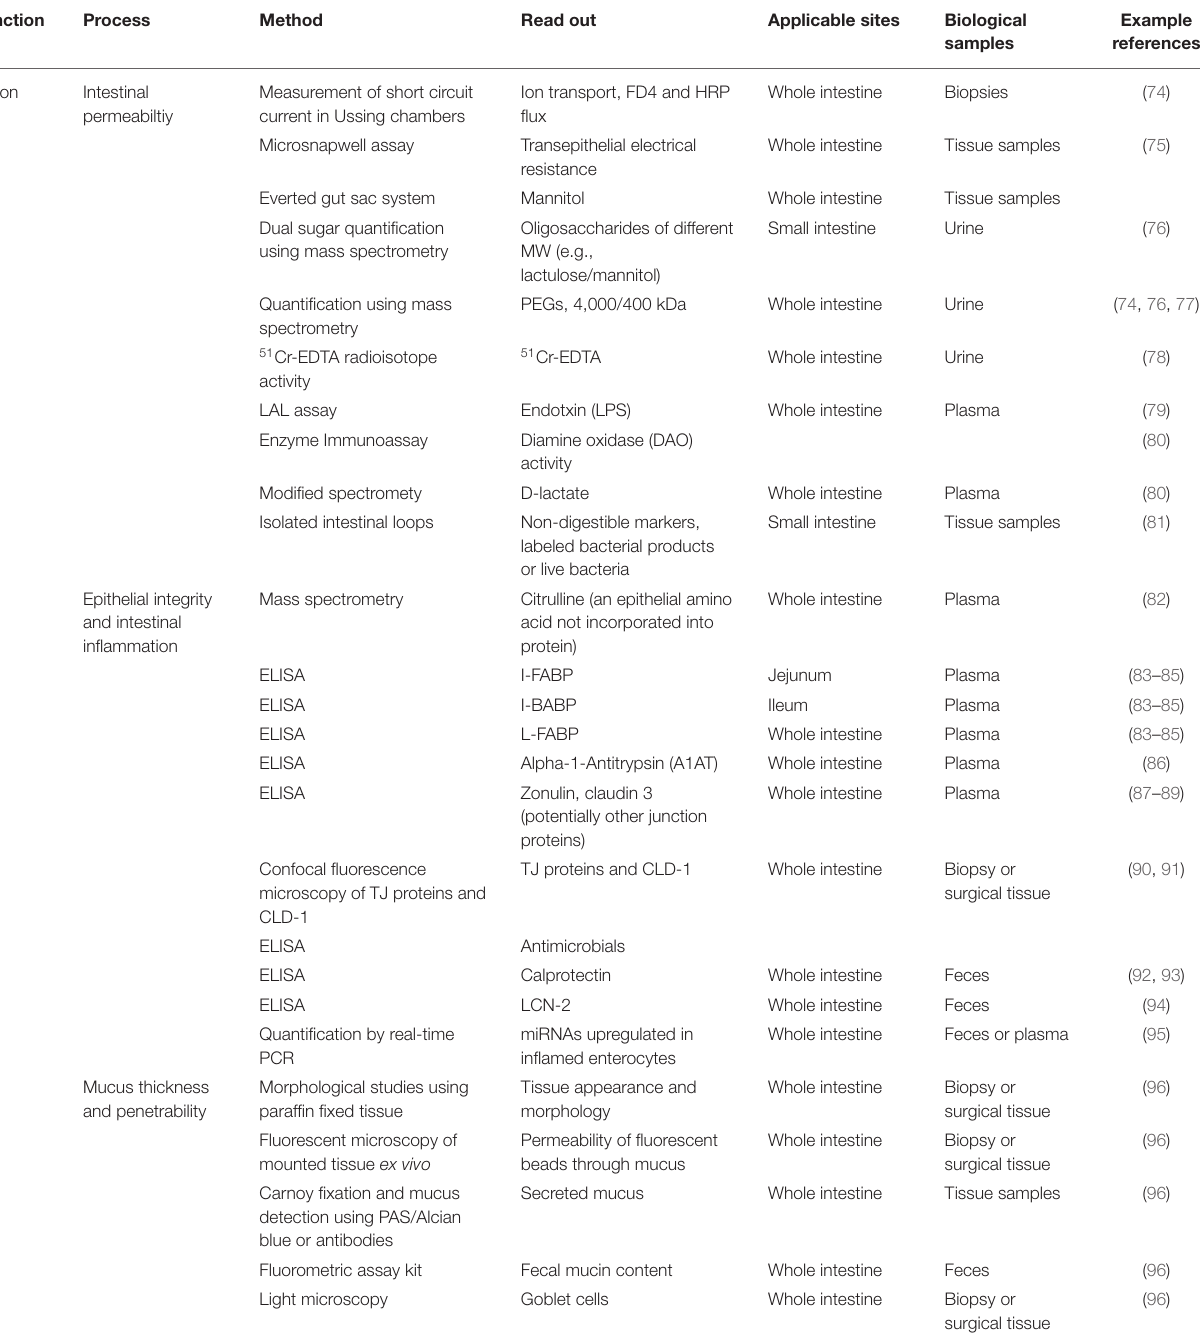
TABLE 4 | Methods described in literature to measure protection from injurious or allergenic material. Gut